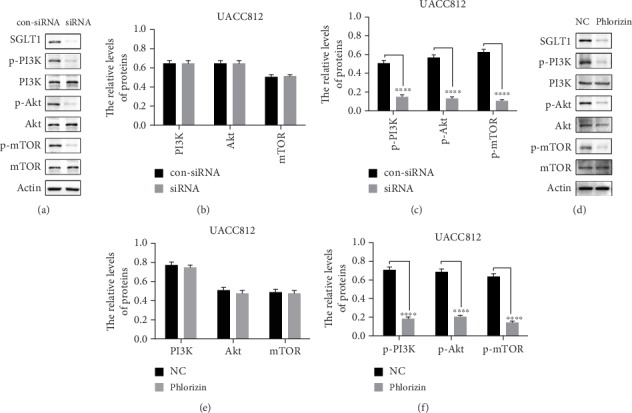
Representative western blot of PI3K/Akt/mTOR pathway-related protein expression levels and quantification relative to actin in UACC812 cells. A representative WB detection result of PI3K/Akt/mTOR pathway-related protein expression levels in (a) SGLT1 siRNA and (d) phlorizin treatment. The relative levels of PI3K/Akt/mTOR protein in (b) SGLT1 siRNA and (e) phlorizin treatment. The relative levels of p-PI3K/p-Akt/p-mTOR protein in (c) SGLT1 siRNA and (f) phlorizin treatment. The results shown were representative of at least three independent experiments; ∗∗∗∗p < 0.0001.